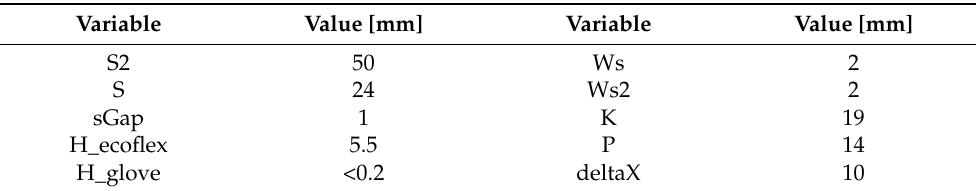
Figure 3. Labelled sensor diagram. Table 4. Ecoflex EDM tag dimensions. Table 2. Ecoflex tag dimensions.